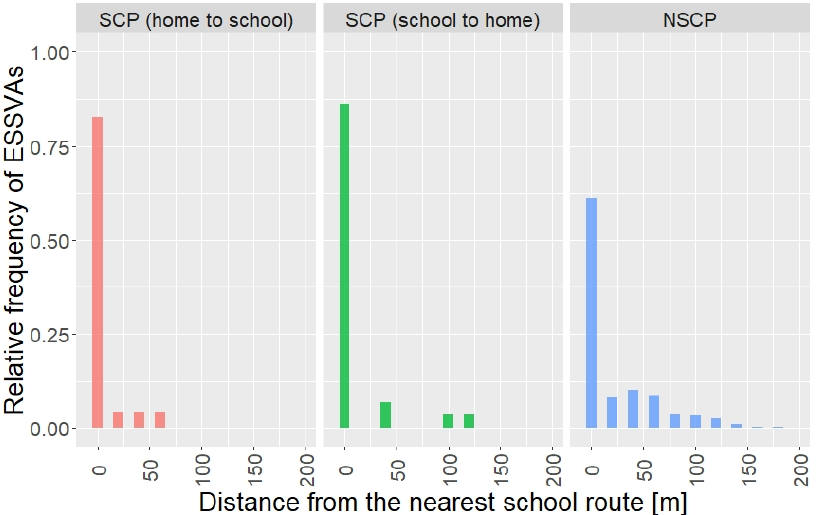
Figure 4. Distribution of the occurrences of ESSVAs in target area by the distance from the nearest school route and travel purpose.